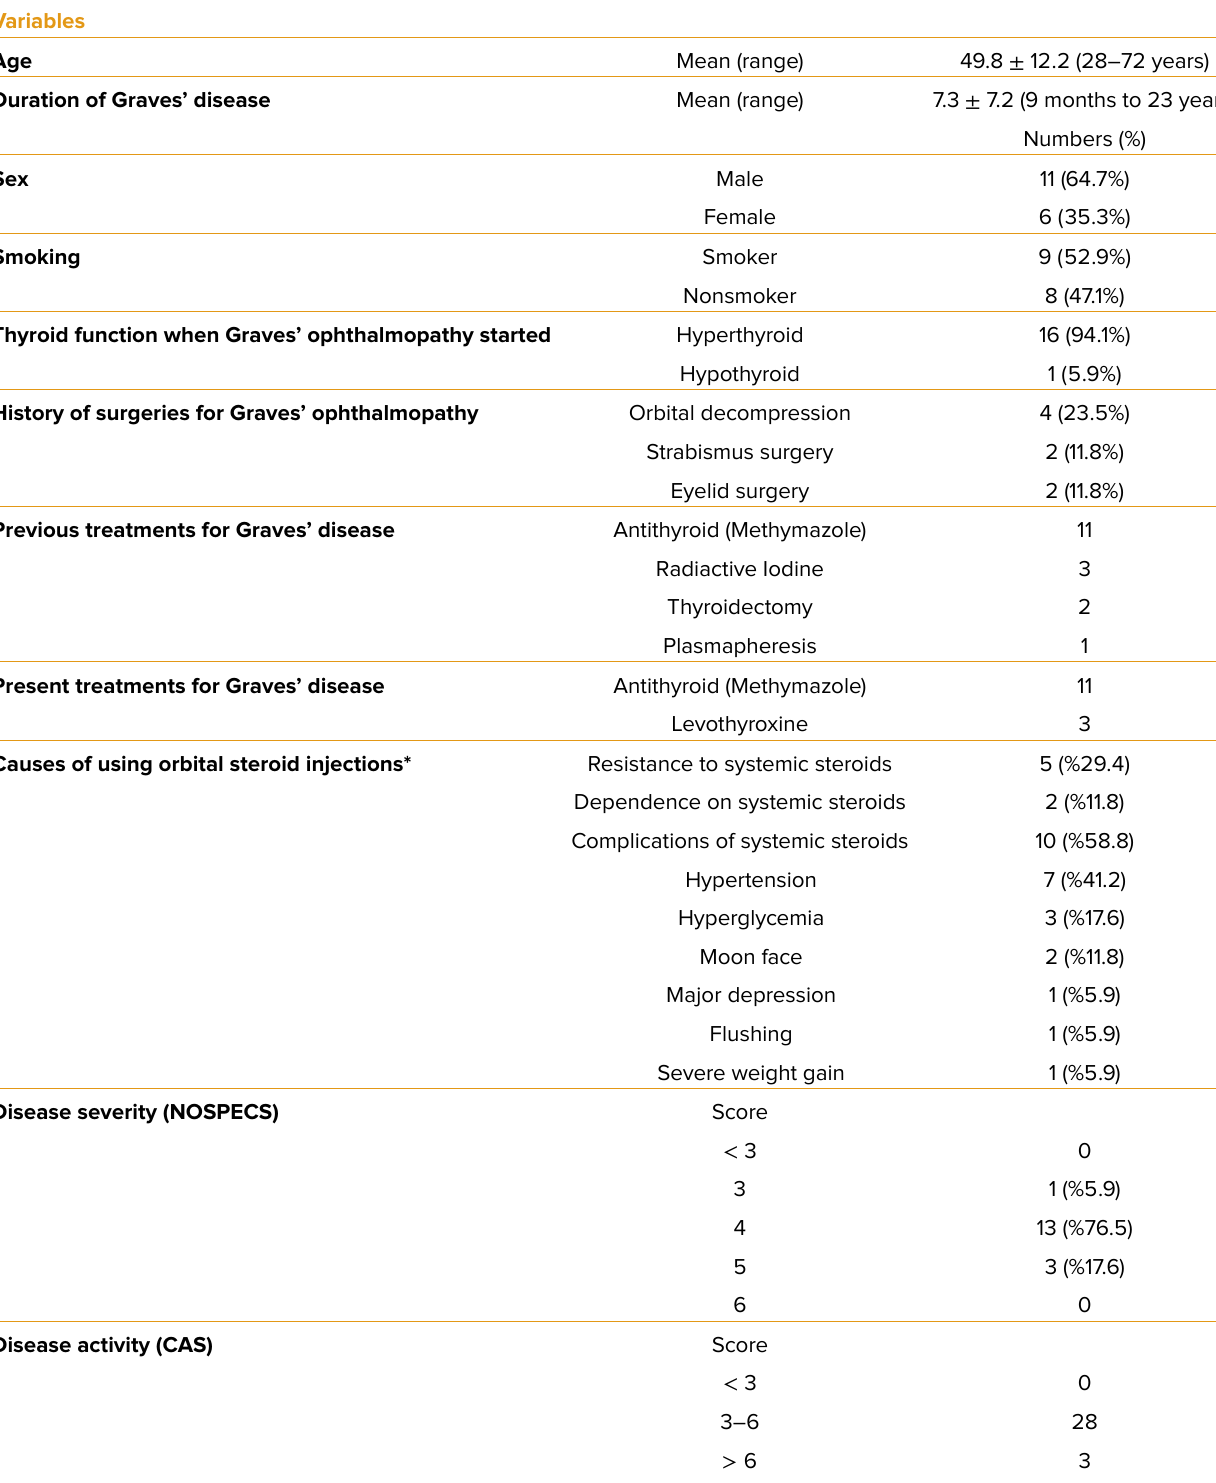
Table 1. Clinical and paraclinical characteristics of patients